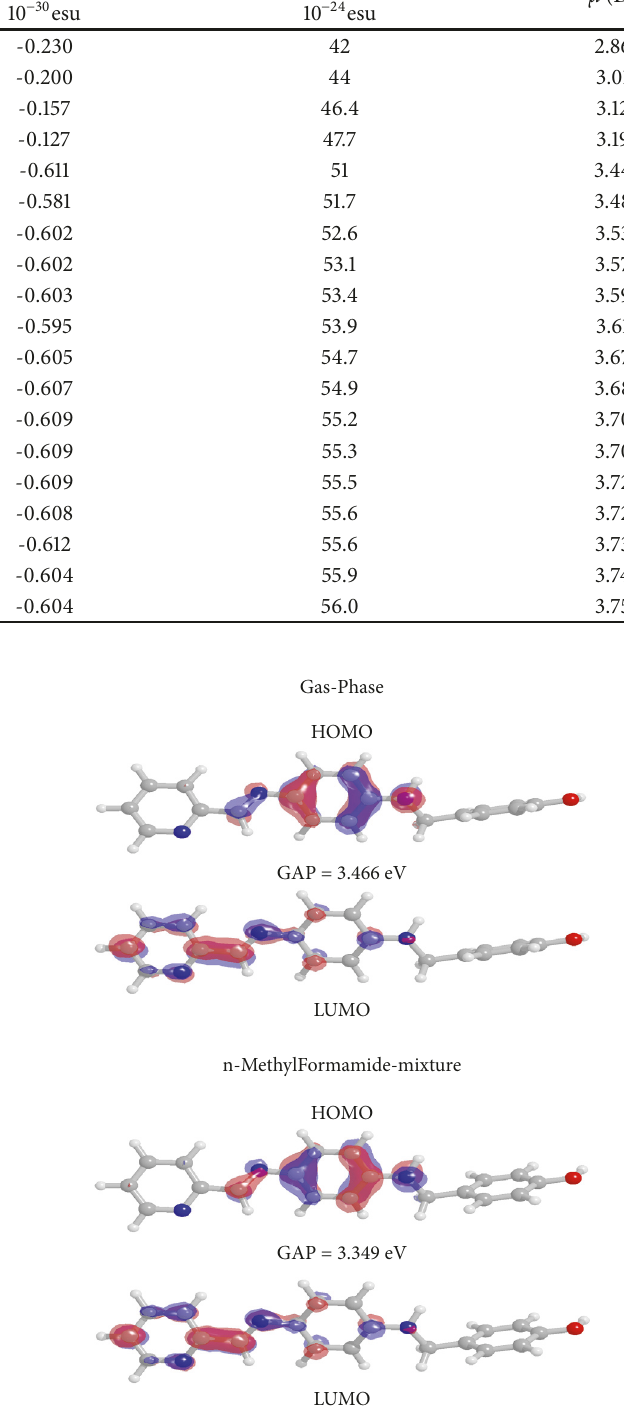
Figure 3: HOMO and LUMO in n- methyl formamide mixture. moment ( 𝛽 || 𝑧(0; 0, 0) ), and the second hyperpolarizability ⟨𝛾(0; 0, 0, 0)⟩ both in gas-phase and in several solvent media. As can be noted, the values of 𝜇 , ⟨𝛼(0; 0)⟩ and ⟨𝛾(0; 0, 0, 0)⟩ increase with the increasing of the 𝜀 -values (Figures 5(a),